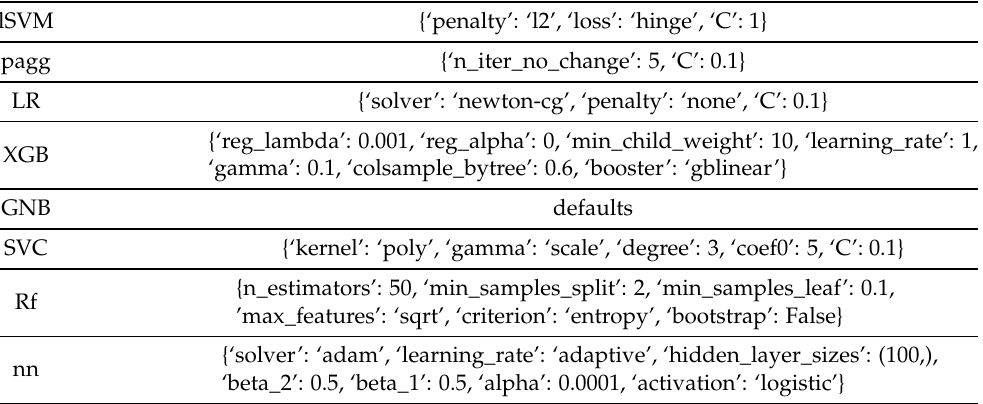
Table 2. The fixed hyper-parameters found to optimize performance on the set of tested classifiers.